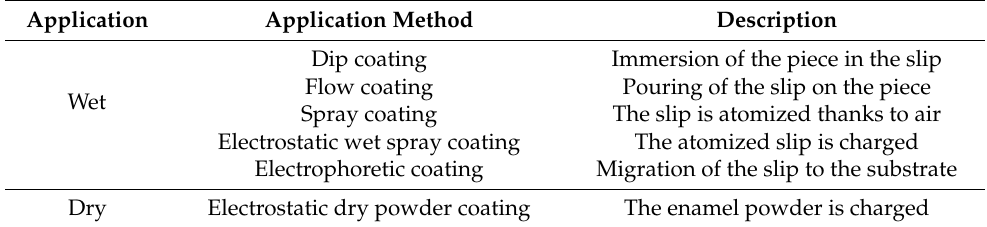
Table 2. Application techniques for enameling of